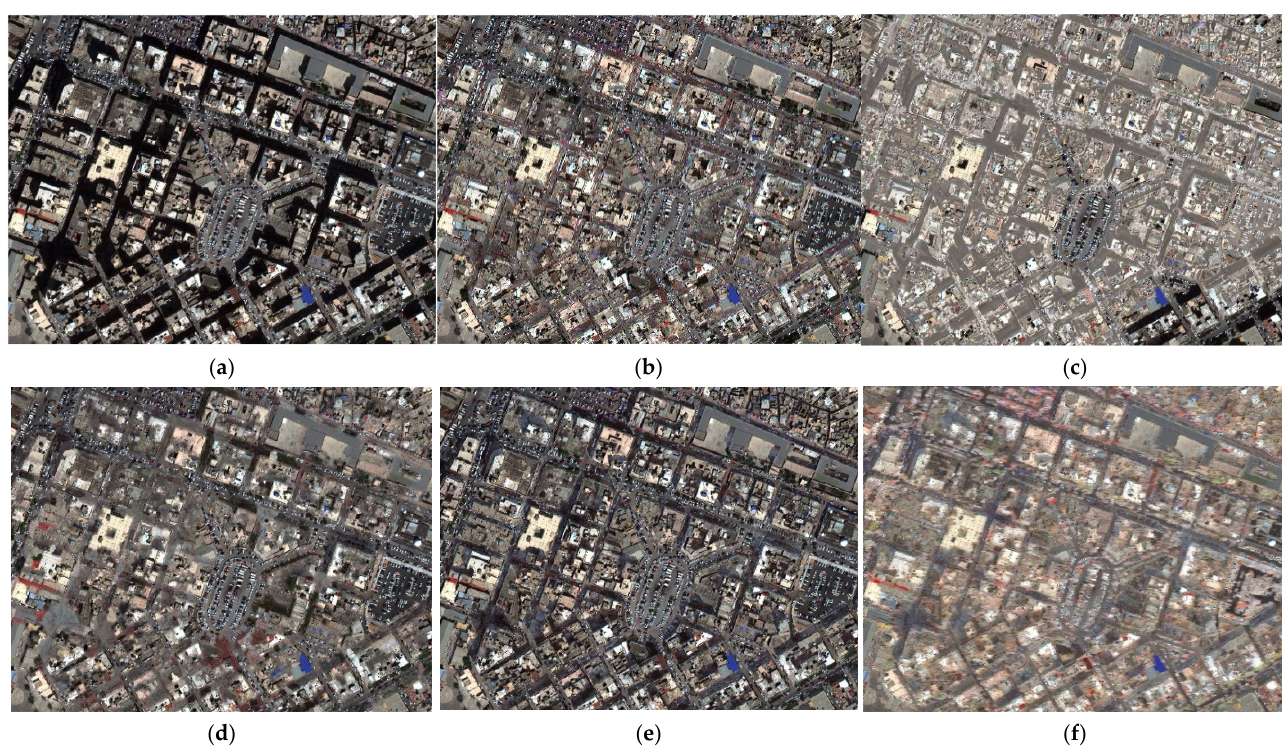
Figure 18. Shadow removal comparison of experimental data 2: ( a ) original image; ( b ) proposed; ( c ) Shor’s; ( d ) Guo’s; ( e ) Yu’s; and ( f ) Bauer’s.